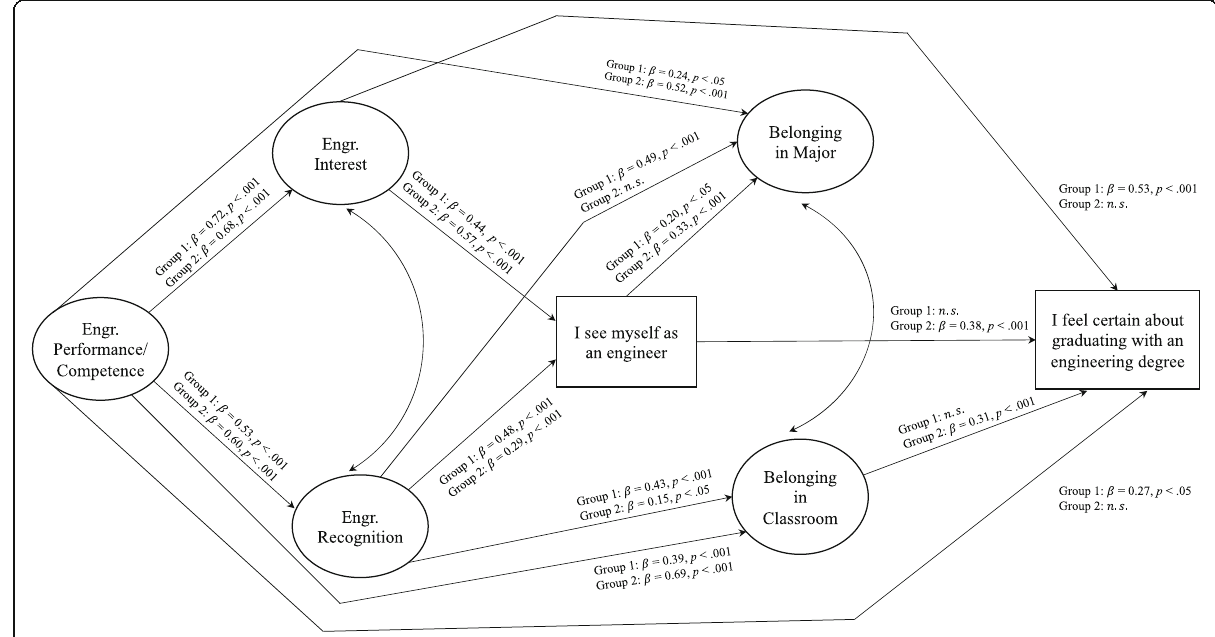
Fig. 1 Multigroup structural equation models predicting persistence beliefs for minoritized women and majority women. Only significant paths are represented. Group 1 represents paths for minoritized women and Group 2 represents paths for majority